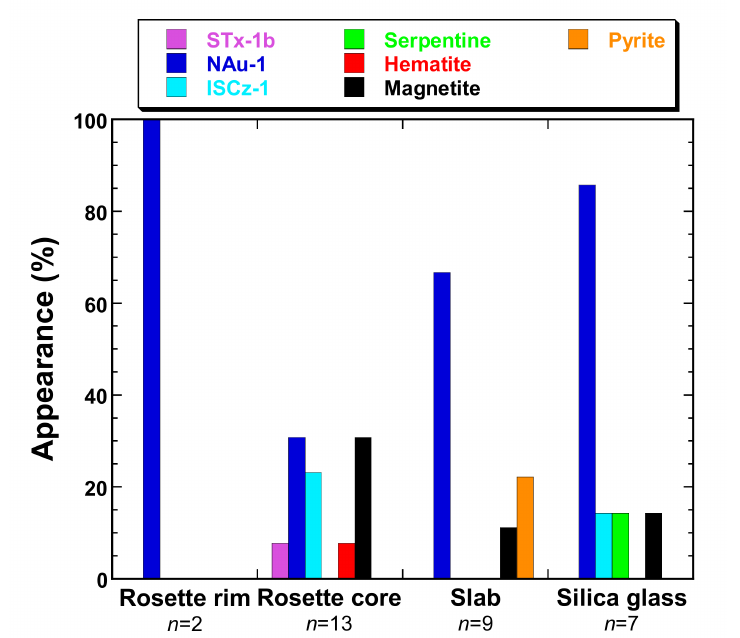
Figure 4. Fe-bearing minerals contributing to the analytical spots except for the carbonates (magnesite and